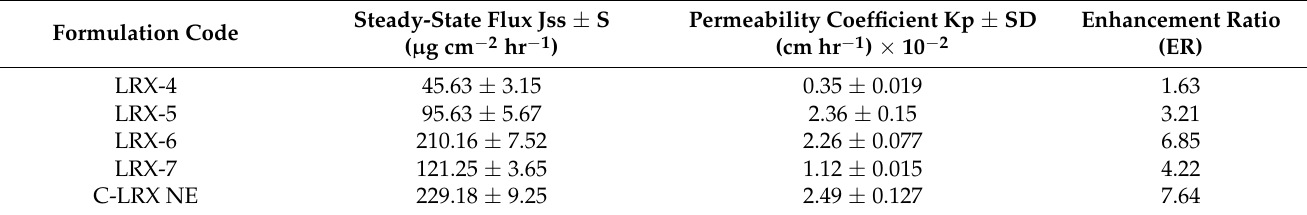
Table 6. Permeability parameters for selected LRX-NE formulations.